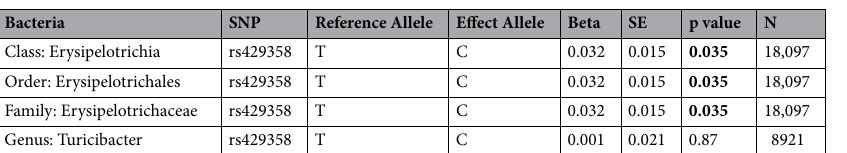
Figure 6. The phylogenetic branch defined by Erysipelotrichia and its lower taxa shows a significant association with APOE in male mice. All depicted bacteria were significantly associated with APOE status. The relative abundance of these bacteria increased in a stepwise fashion from APOE2 to APOE3 to APOE4. P values have been corrected using an FDR approach. ( A–C ) Are the plots depicted using the dominant model representation, while ( D–F ) are the plots depicted using the co-dominant model representation. These results are derived from 3-month male mice. Bacteria